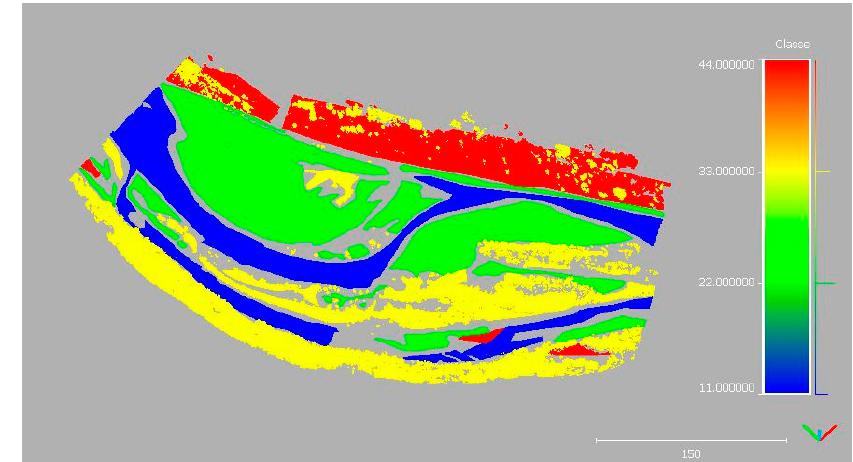
Figure 11. Manual assignment in the training dataset. Water (blue), gravel bars (green), vegetation Figure 11. Manualassignmentinthetrainingdataset. Water(blue), gravelbars(green), vegetation(yellow), (yellow), ground/soils (red). ground / soils